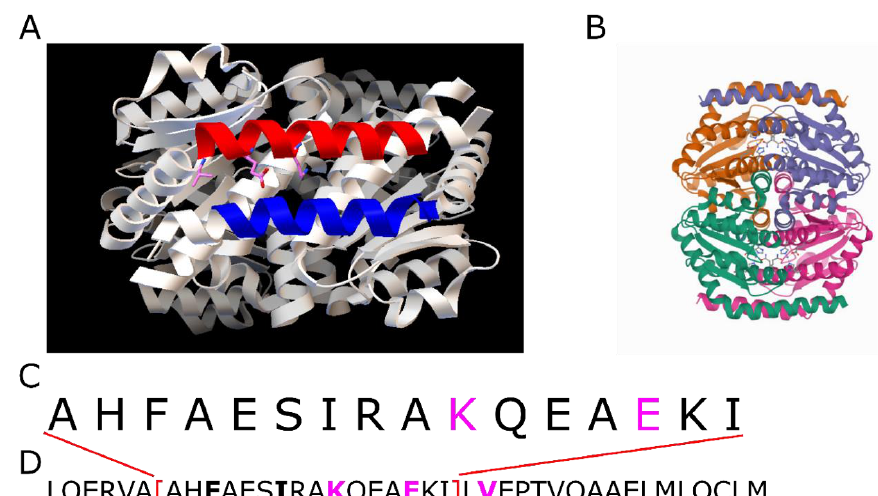
Figure 6. PDB-ID 5i01. ( A ): Detailed view on the coiled coil. The red α -helix exhibits the demanding [4, 3, 4, 4]-decomposition. The blue α -helix is the interaction partner for the formation of the coiled coil. ( B ) Shows a total view on the protein with different colors for its subunits. ( C ): Amino acid sequence of the coiled-coil range analyzed by the CCdb. ( D ): Complete sequence of the α -helix. Contact residues of the coiled coil are bold. The contact residues of the [4, 4]-repeat are colored in magenta, corresponding to ( A ). 6fjx: The PDB-ID contains the aldehyde dehydrogenase of Thermus thermophilus [23]. Upon reduction of NAD(P) the enzyme oxidizes a broad range of aldehydes into the corresponding carboxylic acids. The coiled coil is located at the surface of the protein (see Figure 7). As in PDB-ID 5i01, the [4, 4]-repeat is located at the kink of the coiled coil. The kink in combination with the high pitch angle, i.e., the high rotational displacement of the α -helices from a parallel alignment, causes CCdb to only recognize a small window of the entire coiled coil.